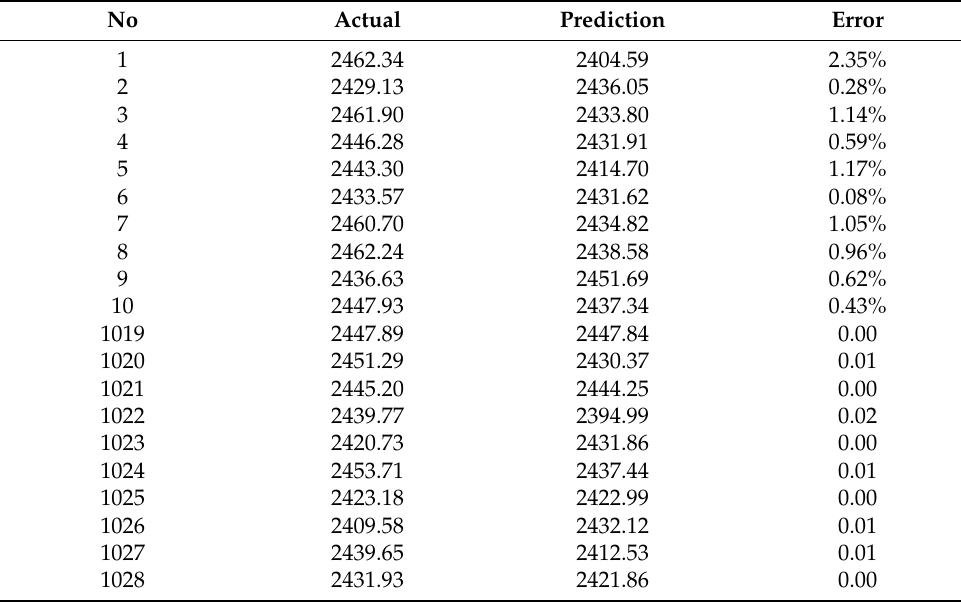
Table 6. CCPP heat rate actual prediction with